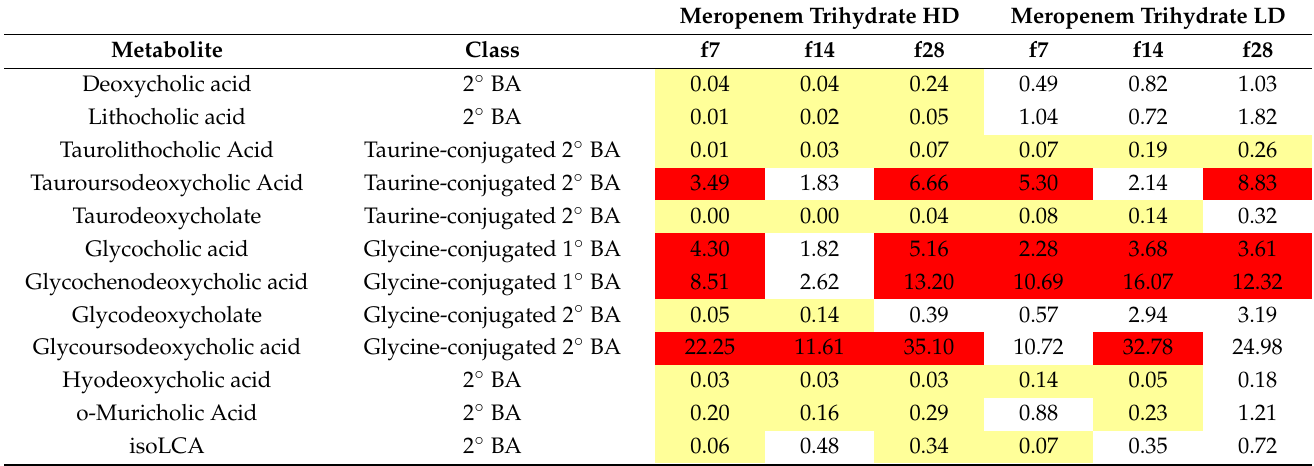
Table 7. Meropenem-induced plasma BA fold changes in female (f) Wistar rats (N = 5 per group) dosed with 100 (LD) and 300 (HD) mg/kg bw/day observed on 7, 14, and 28 days (f7, f14, and f28). Statistically significant changes (Welch t -test; p -value < 0.05) are shown where red boxes